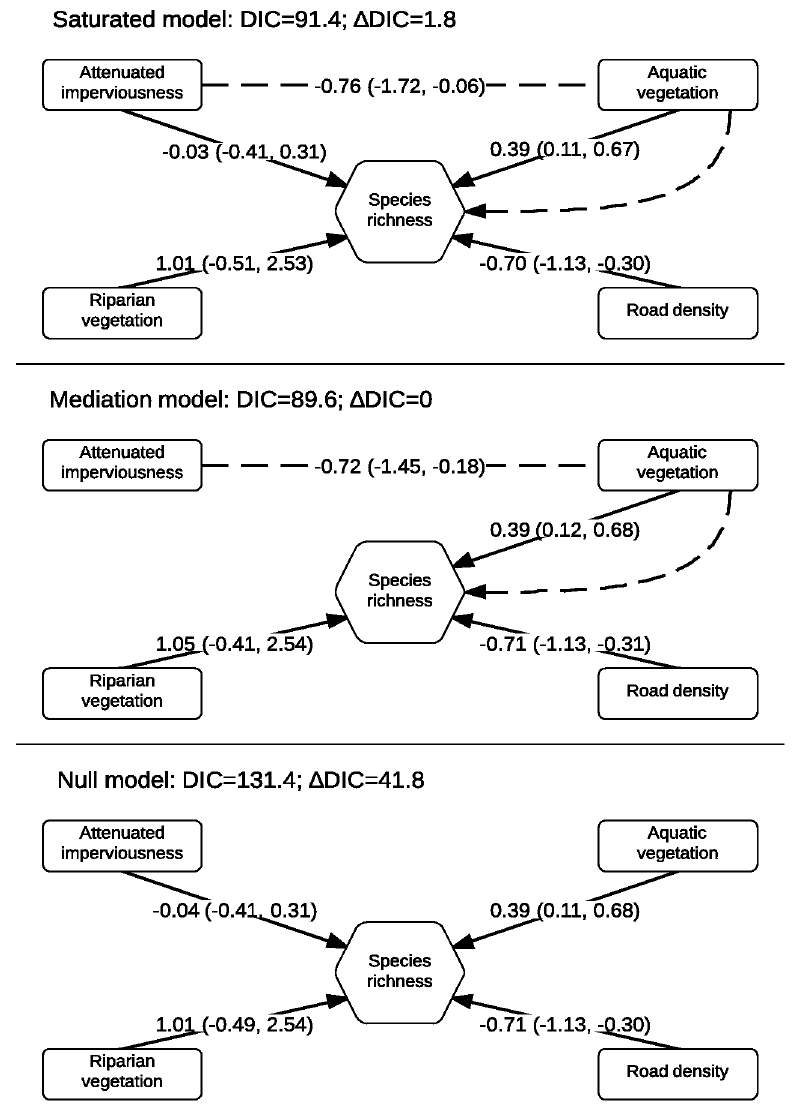
Figure 4. Path diagrams for the structural equation models fitted to species richness data. The saturated model (top) includes both direct effects of attenuated imperviousness (AI) and indirect effects through modification of aquatic vegetation. The mediation model only incorporates indirect effects of AI (centre), whereas the null model only includes direct effects for all predictors (bottom). DIC is the deviance information criterion and ∆DIC the difference between DIC scores of the best model and a given model. The dashed arrow represents the total indirect effect of attenuated imperviousness on species richness (by affecting aquatic vegetation). Solid arrows indicate direct effects. Numbers next to arrows indicate the standardized coefficient for that path (95% credible intervals in